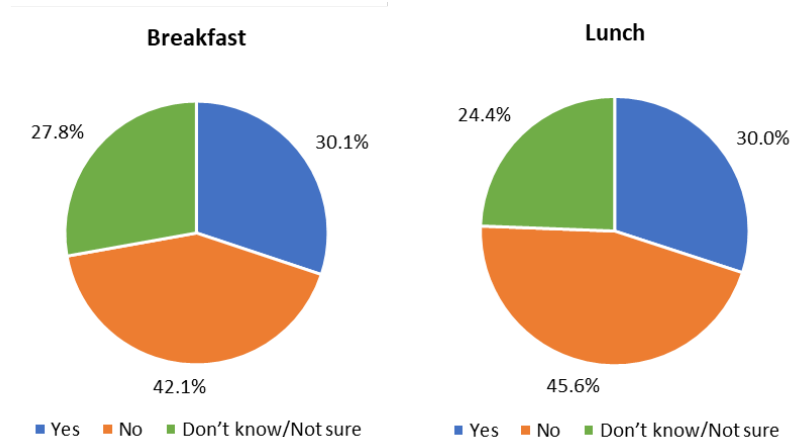
statistical significance for pairwise comparisons is indicated as follows: a differences between medium and small; b differences between large and small; no significant differences were observed between medium and large.